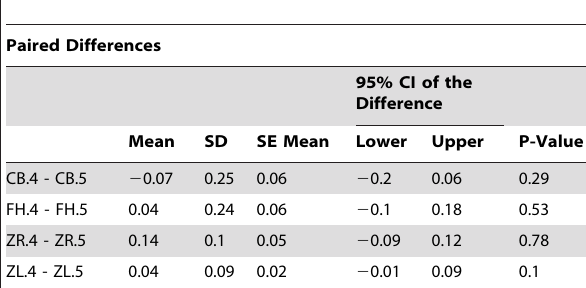
Table 3. Mean differences (mm) and 95% confidence interval (CI) between superimpositions registered on the left zygomatic arch.